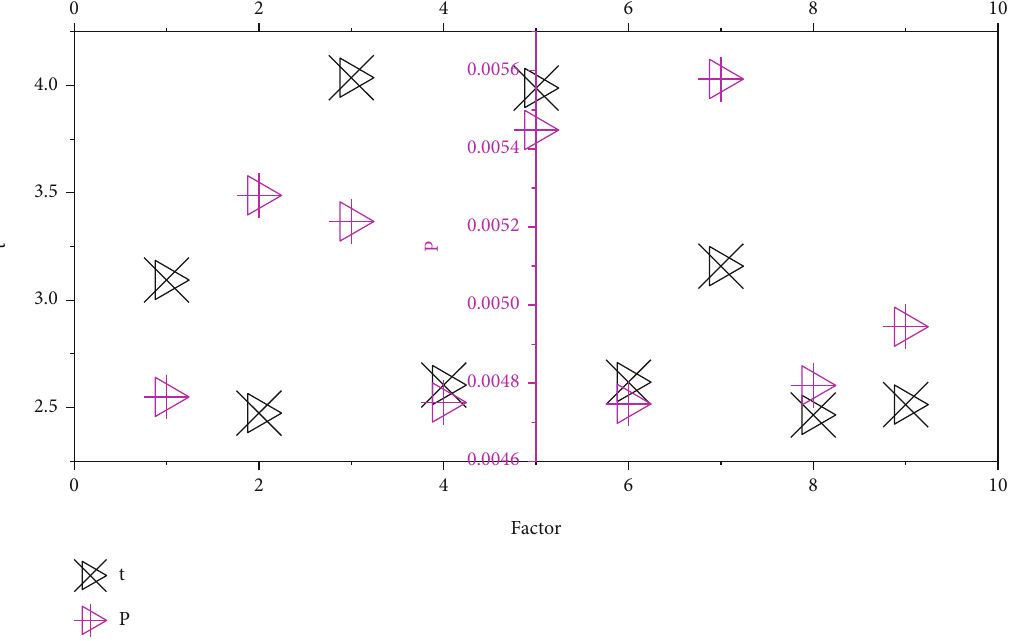
Figure 5: Comparison of t value and P value of SCL-90 assessment results before and after music education and psychological